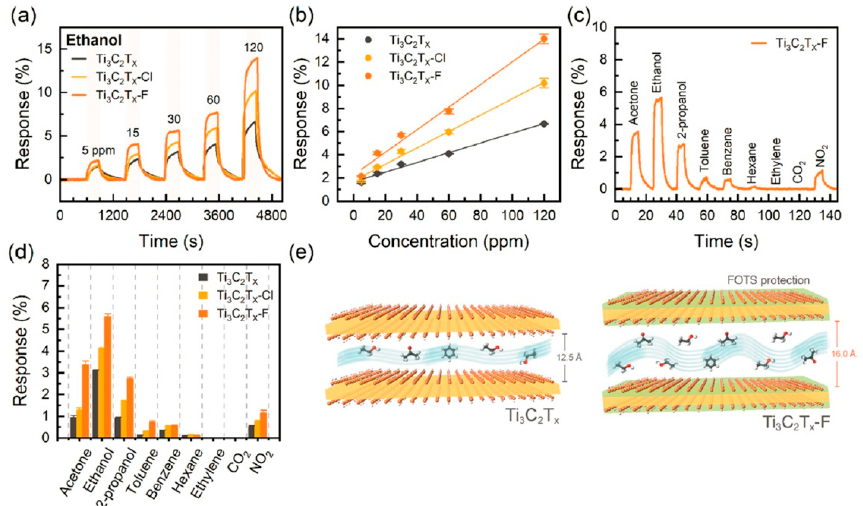
Figure 4. ( a ) Dynamic response curves of Ti 3 C 2 T x , Ti 3 C 2 T x -Cl, and Ti 3 C 2 T x -F sensors upon exposure to varying concentrations of ethanol from 5 to 120 ppm, and ( b ) the response versus ethanol concentration plots for the three sensors derived. ( c ) Sensing response of Ti 3 C 2 T x -F sensors toward 30 ppm of acetone, ethanol, 2-propanol, toluene, benzene, hexane, ethylene, carbon dioxide, and nitrogen dioxide at RT. ( d ) Maximal response changes upon exposure to various gases. ( e ) Schematics of Ti 3 C 2 T x and Ti 3 C 2 T x -F upon exposure to VOCs. Reprinted with permission from [92].